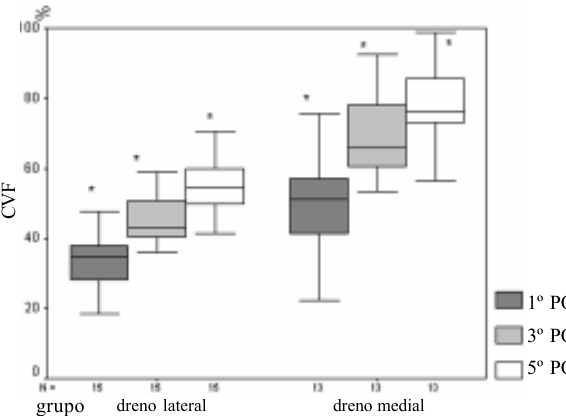
Fig. 2 - Distribuição representativa das alterações da CVF em percentual nos 1º, 3º e 5º dias de PO em relação aos valores pré- operatórios, comparação entre os grupos com inserção do dreno pleural nas regiões lateral e medial, considerando como 100% o valor basal do pré-operatório. * p <